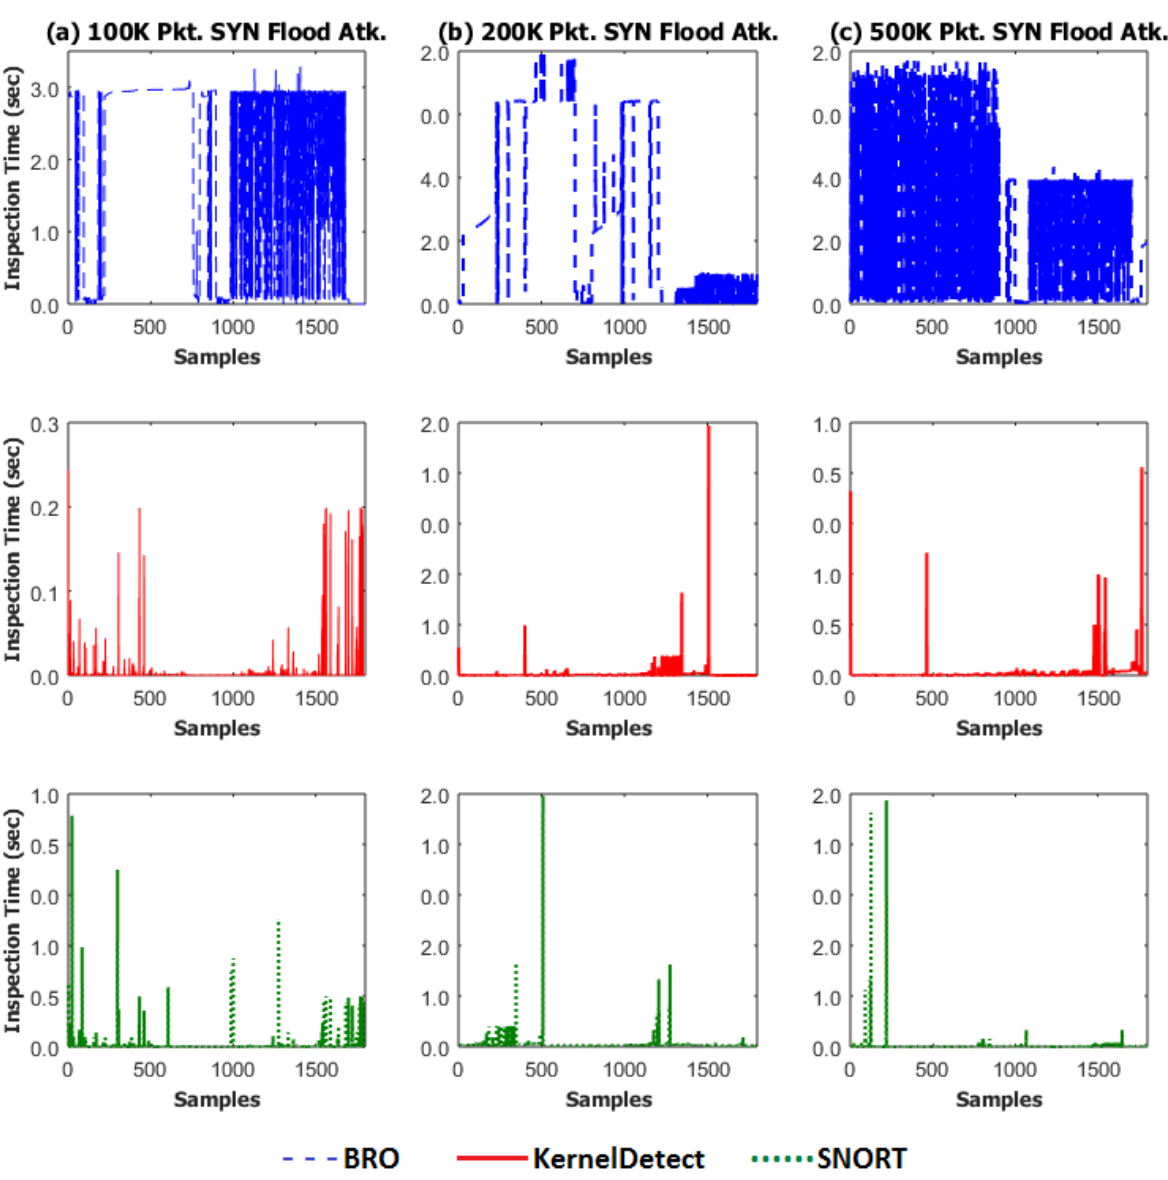
Figure 4. A comparative analysis of the inspection time for each IDS under 100K, 200K and 500K SYN flagged packet DoS attack using a 5 second threshold